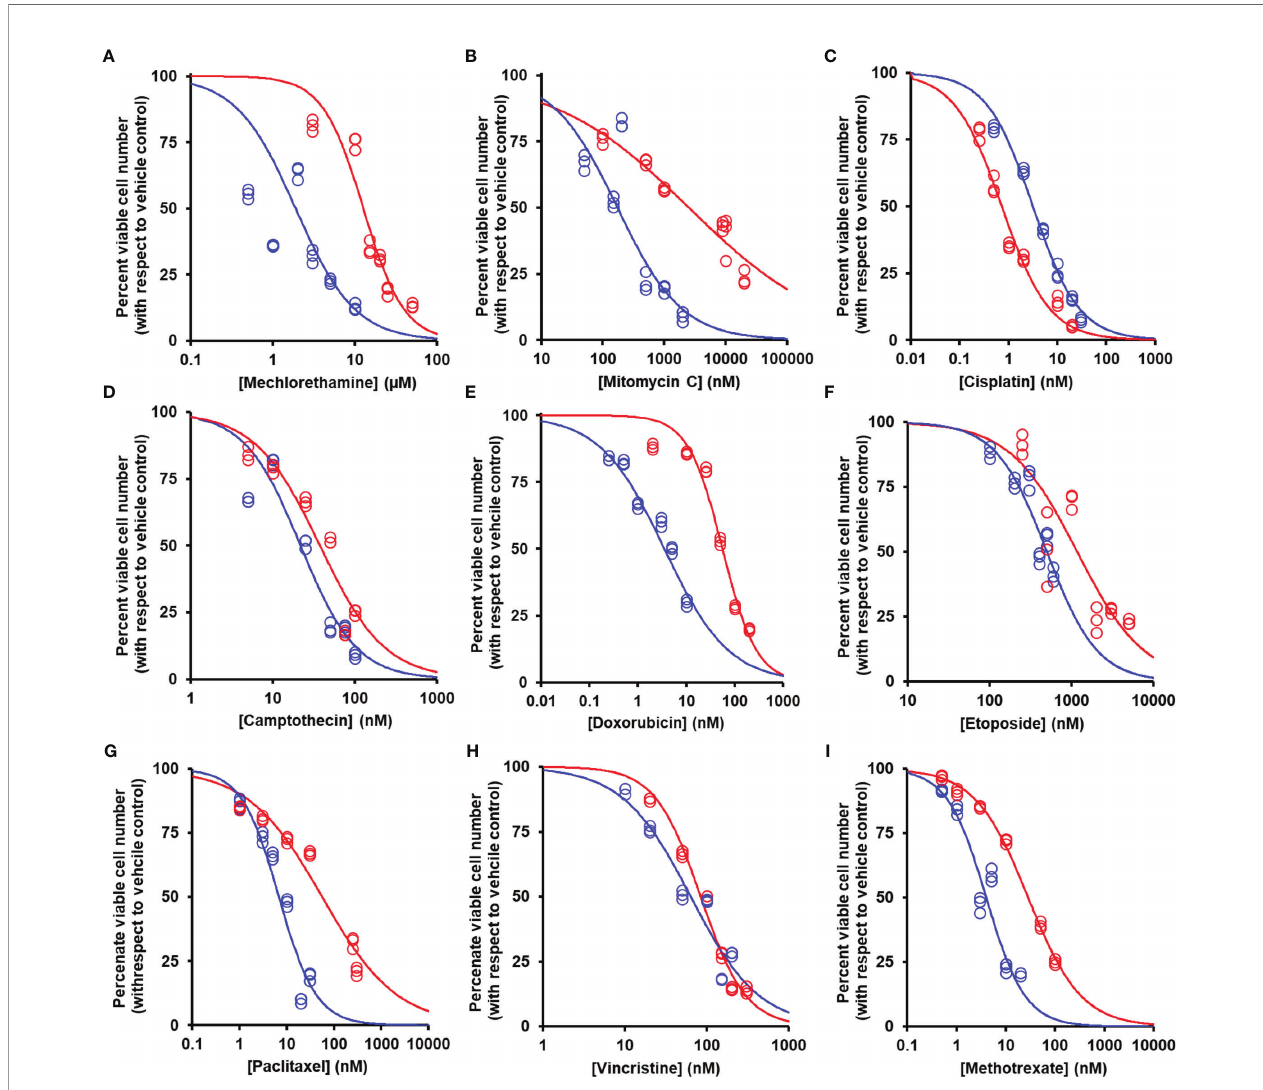
FIGURE 2 | Suppression of antiperoxidative activity of clinical antitumor drugs by overexpression of glyoxalase. Color code for blue data points and curve: blue, empty vector transfected; red, Glo1+ vector transfected. (A) Mechlorethamine. GC 50 = 1.90 ± 0.11 µM, n = 1.20 ± 0.09 (empty vector) and GC 50 = 12.70 ± 0.90 µM, n = 1.75 ± 0.26 (Glo1+; sevenfold resistance). (B) Mitomycin C. GC 50 = 174 ± 29 nM, n = 0.83 ± 0.12 (empty vector) and GC 50 = 2,541 ± 360 nM, n = 0.39 ± 0.03 (Glo1+; 15-fold resistance). (C) Cisplatin. GC 50 = 3.17 ± 0.35 µM, n = 0.92 ± 0.04 (empty vector) and GC 50 = 0.73 ± 0.05 µM, n = 0.89 ± 0.07 (Glo1+; 0.2-fold resistance). (D) Camptothecin. GC 50 = 21.8 ± 2.2 nM, n = 1.28 ± 0.15 (empty vector) and GC 50 = 37.6 ± 3.3 nM, n = 1.12 ± 0.12 (Glo1+; twofold resistance). (E) Doxorubicin. GC